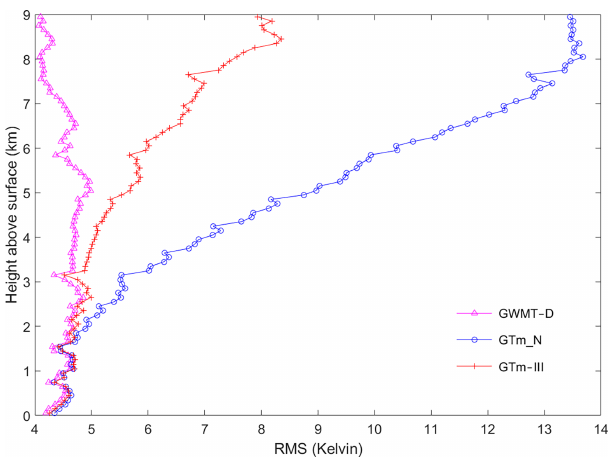
Figure 10. RMSE profile of the T m from GTm-III, GTm_N, and GWMT-D models. The reference T m values are derived from records of 585 radiosonde sites in